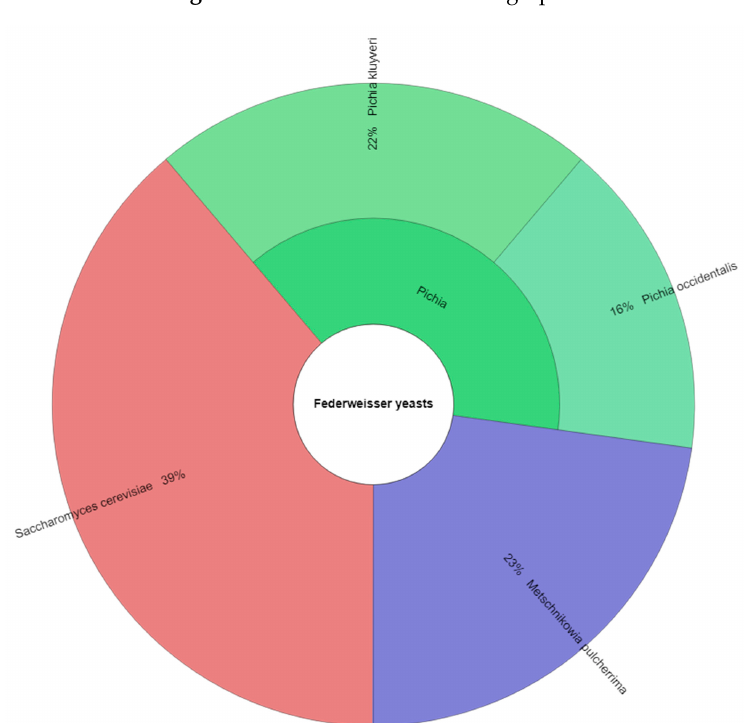
Figure 1. Yeasts isolated from the grapes.